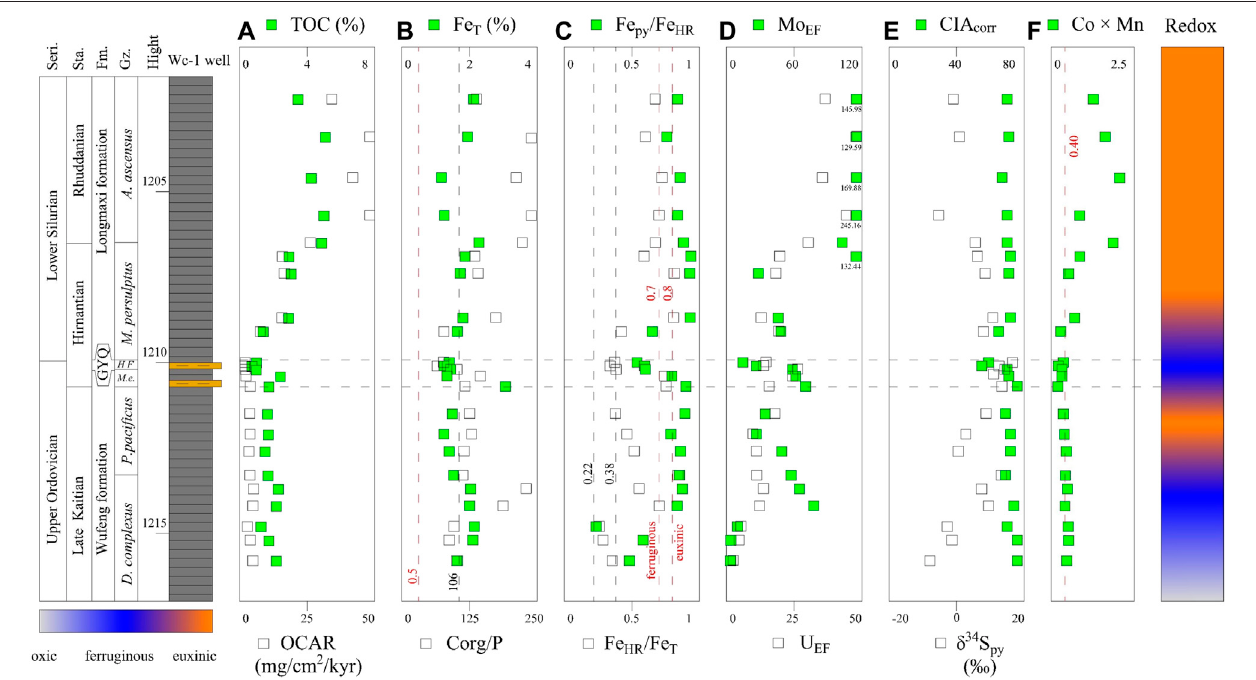
FIGURE 2 | Chemostratigraphic pro fi les of (A) total organic carbon (TOC) and organic carbon accumulation rate (OCAR), (B) FeT and Corg/P, (C) FeHR/FeT and Fepy/FeHR, (D) MoEF and UEF, (E) CIAcorr and δ 34Spy and (F) Co × Mn for Wc-1 well. The value of 106 for C org /P was used to distinguish suboxic – anoxic conditions (Algeo and Ingall, 2007). The values between 0.22 and 0.38 (for Fe HR /Fe T ) were used to distinguish oxic – suboxic and suboxic – anoxic conditions. And values of 0.7 – 0.8 (for Fe